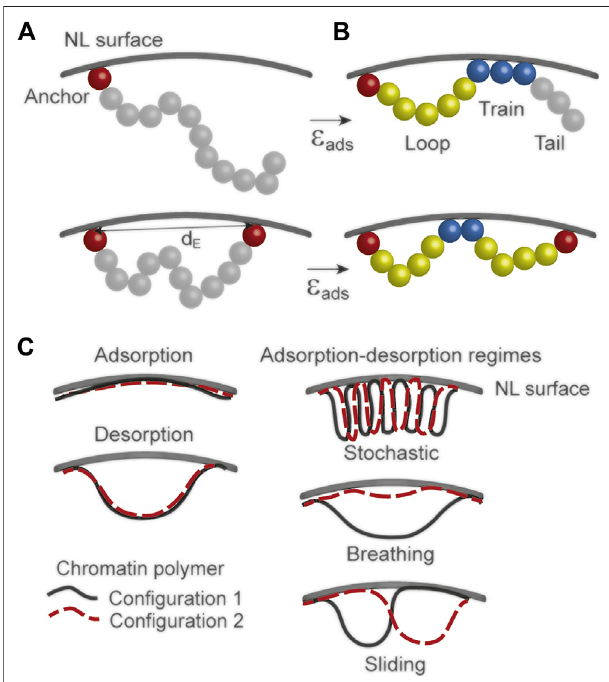
FIGURE 3 | Polymer modeling of chromatin interactions with a NL surface (A) Chromatinismodeledasachainofbeadspinnedtoahardsurface by one or two anchors (red beads) separated by a Euclidian distance d E . This distance can be tuned at the start of simulations to generate a loose or stretched polymer chain near the surface (B) During simulations, the polymer changes conformation near the surface. Applying an attraction potential ( ε ads ) from the surface elicits loop, train and tail polymer con fi gurations whose position,sizeandfrequencyvarybytuning ε ads andphysicalparametersofthe polymer (e.g., stiffness, contour length and d E ) (C) Interpretations of a chromatin polymer behavior at a NL surface, inferred from polymer con fi gurations. Variations in ε ads from the surface leads to full adsorption, full desorption or various adsorption-desorption regimes; adapted from our own work (Brunet et al., 2021).